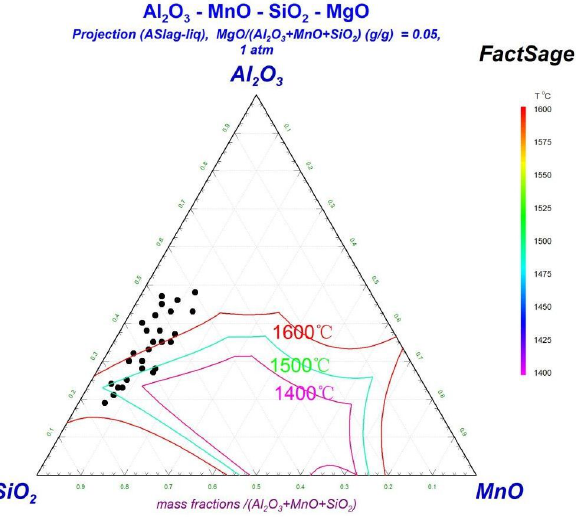
Figure 3: Composition distribution of inclusions in Al 2 O 3 -SiO 2 -MnO phase diagrams for S3